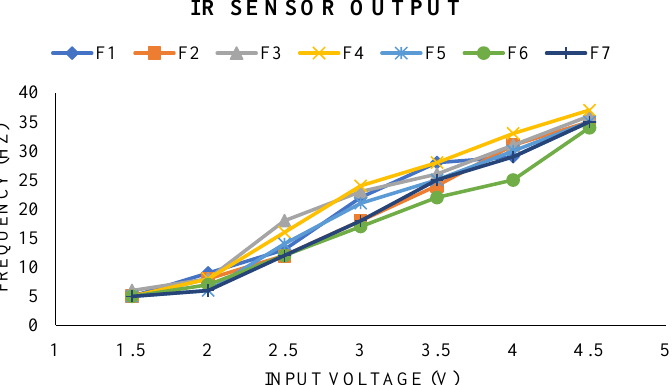
Figure 24. Variation in flapping frequency due to the variable input voltage of the motor. Two IR sensors are positioned side-by-side, and the flapping wing is situated between both sensor wavelengths at a distance of 75 mm, such that the sensors can detect the forward stroke edge and return stroke edge. The time difference between forward and reverse strokes is determined using the CRO channels associated with each sensor. Figure 25 depicts the signals collected from the CRO, where the yellow signal shows the detection of the forward stroke edge, and the pink signal indicates the detection of the return stroke edge by the sensors. Figure 25 reveals that the forward stroke time space is 85.8 milliseconds, and the return stroke time space is 71.3 milliseconds, based on the time space between the yellow and pink signals. As the forward stroke requires more time than the return stroke, this confirms that the quick return mechanism in this system is functional. The above obtained signals are for a 6.14 Hz flapping frequency at an input voltage of 1.5 v. As shown in simulations, structural design constraints caused a delay between the left- and right-wing positions during its flapping movements. i.e., approximately 2 degrees of angular position lag in one of its wings. In the proposed experimental setup using the